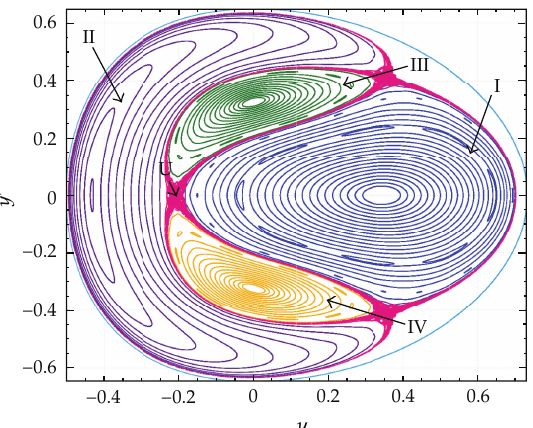
Figure 3: Poincar´e surface of section at E (cid:7) 0 . 21 (cid:5) in fifth order Hamiltonian (cid:6) . We can distinguish the four families (cid:5) I, II, III, and IV (cid:6) plus an unstable invariant point (cid:5) U (cid:6) , which characterizes the case as weakly